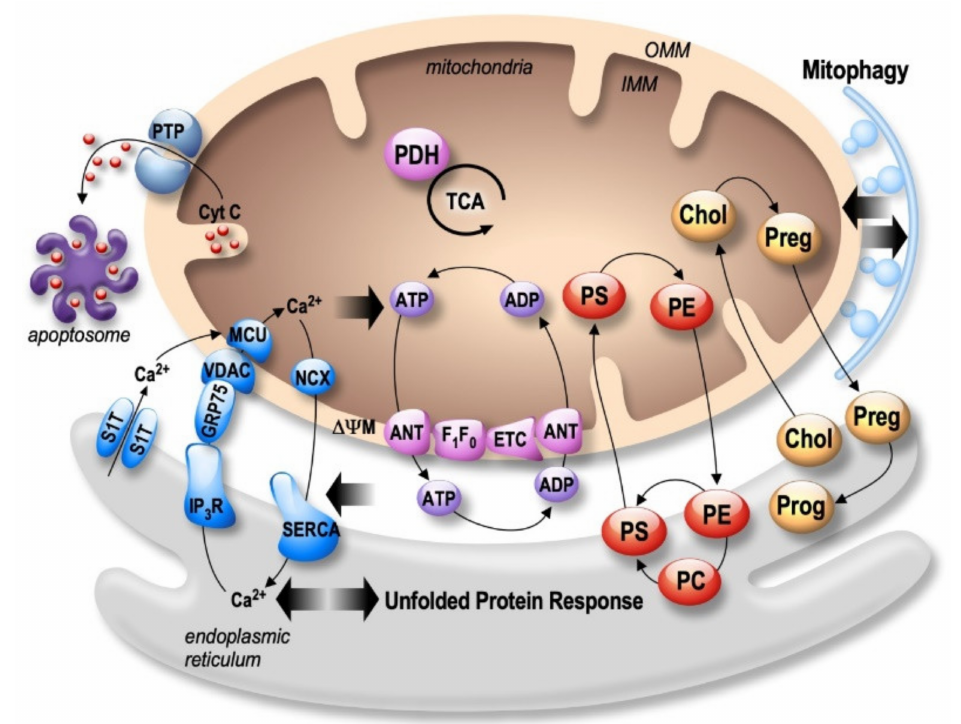
Figure 1. Bidirectional regulation of ER and mitochondria functions in MAMs. Mitochondria Ca 2 +